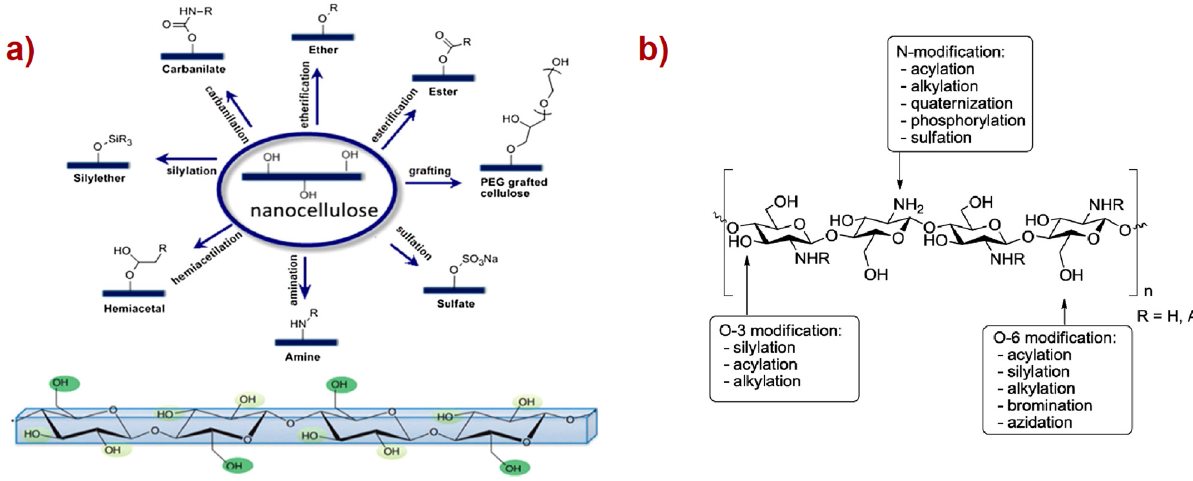
Figure 4: ( a ) General paths for the modi fi cation of nanocellulose ( reproduced from refs. [ 24,25 ]) . ( b ) Regioselective and chemoselective modi fi cations of chitosan [ 26 ]